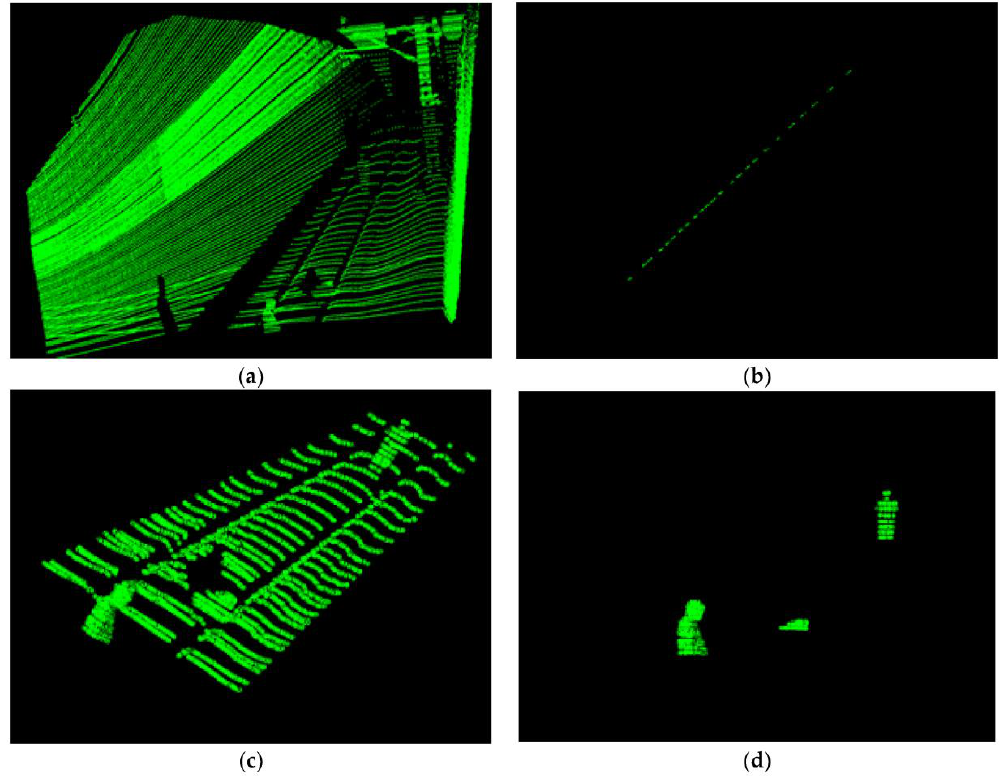
Figure 8. Segment the obstacles. ( a ) Raw data; ( b ) points on a rail; ( c ) segment the ROI; ( d ) points on